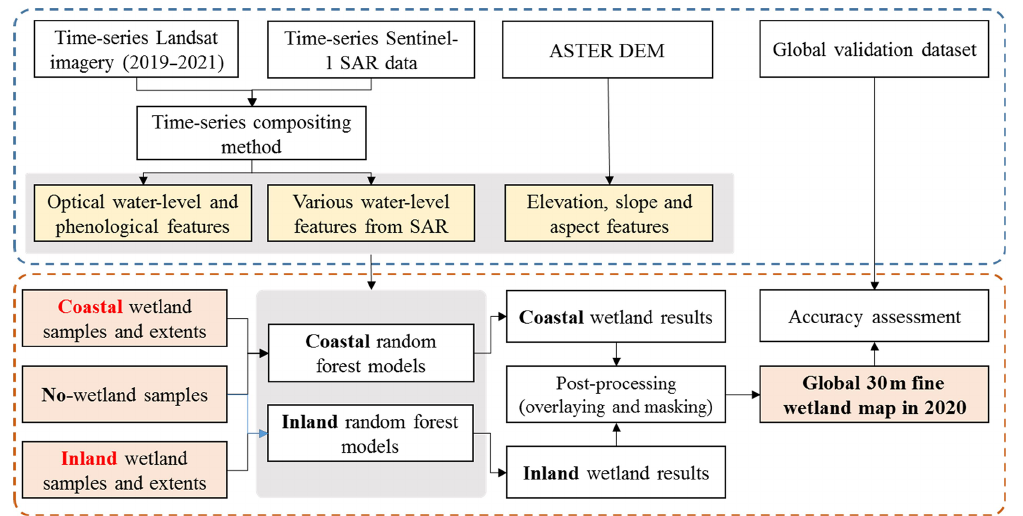
Figure 3. The flowchart of wetland mapping using water-level, phenological and topographical features and a stratified classification strategy.